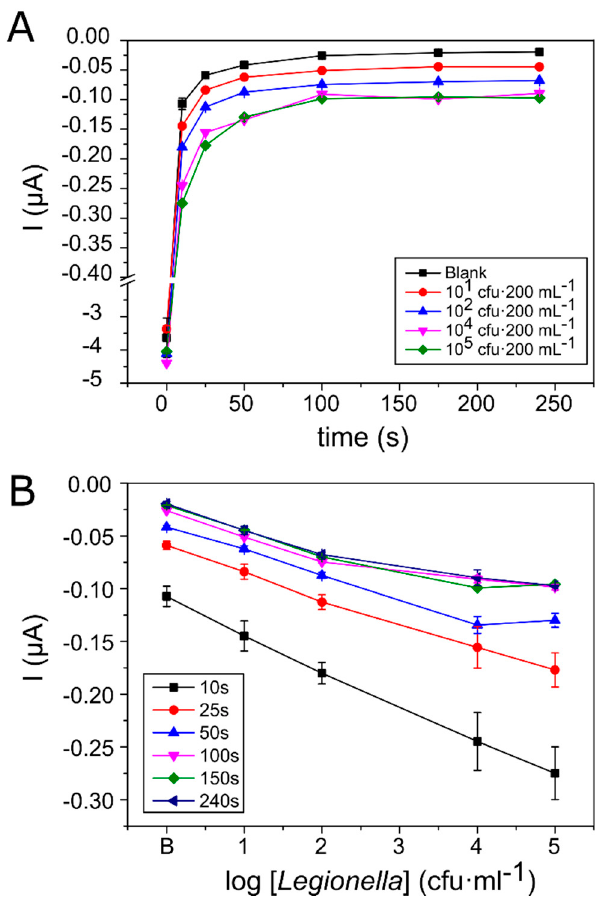
Figure 3. ( A ) Current change response in time, measured for different Legionella concentrations. ( B ) Current changes measured for different Legionella concentrations at different times (from 0 to 240 s). Standard error bars correspond to the measurements made in three different culture replicates of each concentration measured in two different assays ( n = 6).